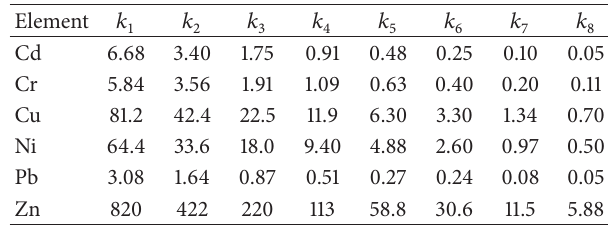
† Values represent means of two replicates. The differences of first-order kinetics constant for Cd among the treatments were tested by one-way ANOVA. In each column, values followed by the same lowercase letter were not significantly different at 𝑃 < 0.05 . ‡ Obtained at Moreno Field Station of the University of California, Riverside, CA. From 1976 through 1981, composted biosolids were applied at dry weight rates of 0 (control), 22.5, and 180Mgha −1 yr −1 , respectively.